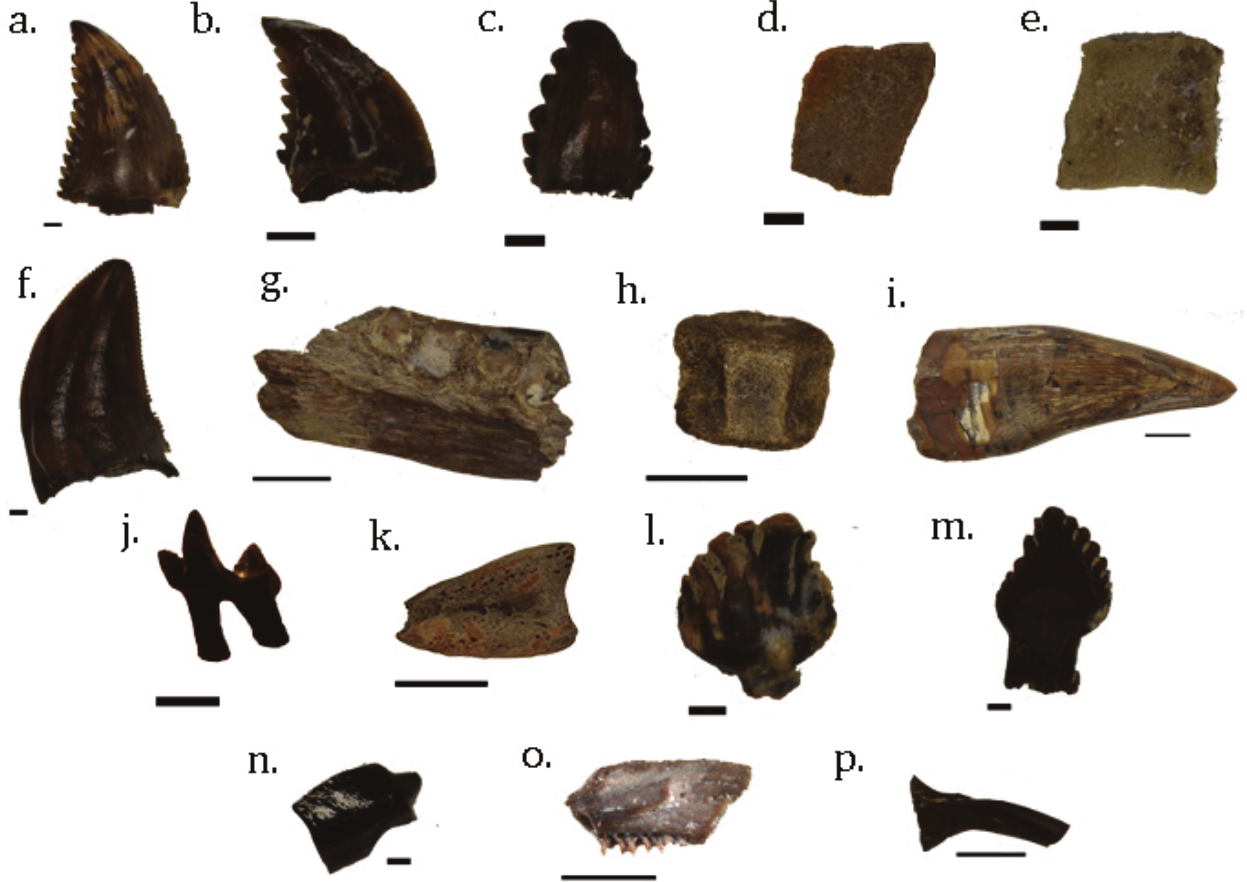
Figure 1. Fossil material from the Morrin microsite locality. a. – c. Troodon teeth. d. & e. Troodon eggshell. f. Dromaosaur tooth. g. perinate hadrosaur dentary (scale = 5mm). h. perinate hadrosaur vertebra (scale = 5mm). i. premaxillary tyranno- saur tooth (scale = 5mm). j. Pediomys tooth. k. perinate ornithomomid claw (scale = 5mm) l. ankylosaur tooth. m. pachyceph- alosaur tooth. n. Holostean A scale. o. anuran maxilla. p. anuran ilium. Uneless otherwise specified, scale bars =